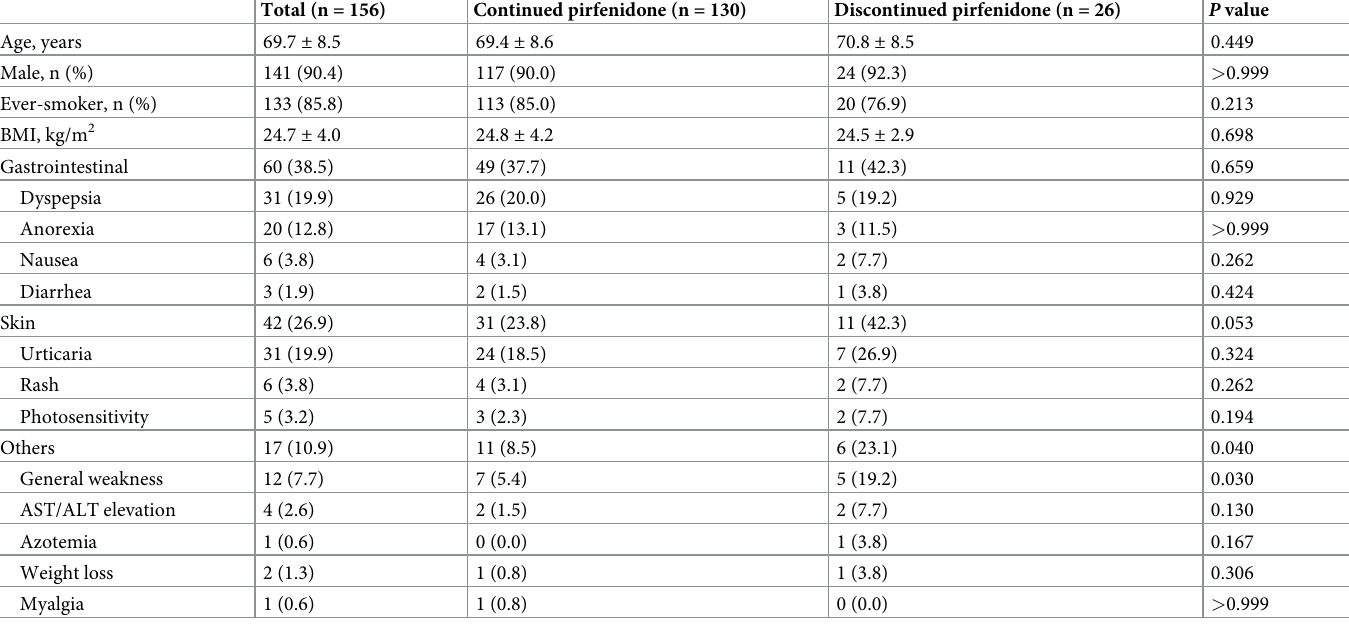
Table 5. Comparison of baseline characteristics and adverse events between patients who continued and discontinued